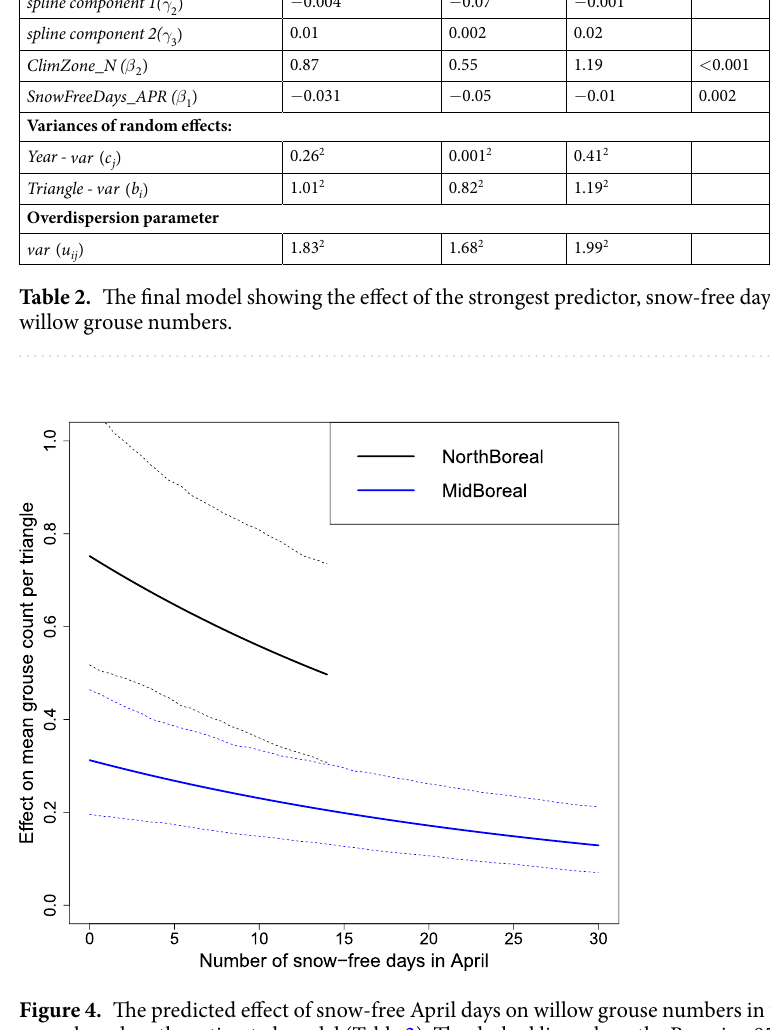
Figure 4. The predicted effect of snow-free April days on willow grouse numbers in the different climatic zones based on the estimated model (Table 2). The dashed lines show the Bayesian 95% credible intervals for the mean. The effect of snow-free April is the same in both regions, even though the lines differ because of the scaling of the y-axis. One additional snow-free day decreases the population by 3.1%, meaning that a year with 5 snow-free April days had ca. 14% less willow grouse than a year with fully snow-covered